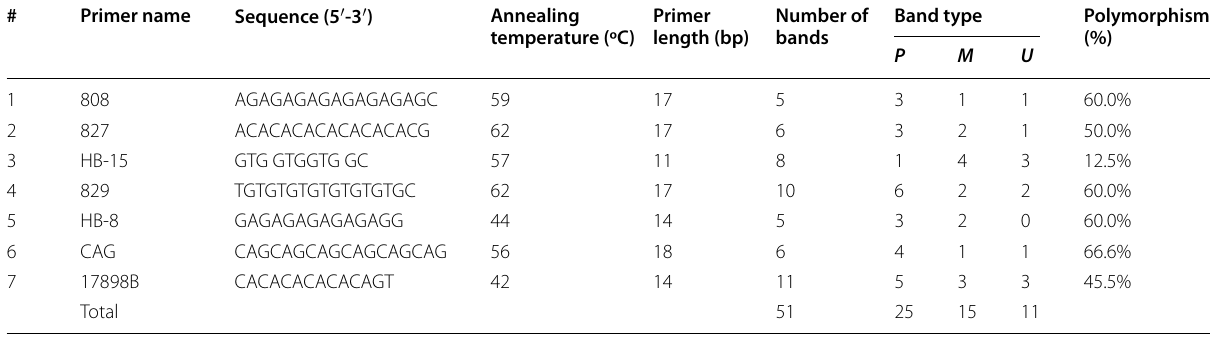
Table 1 List of ISSR primers utilized in this study, their sequences, annealing temperatures, number of bands produced by each primer, and polymorphism